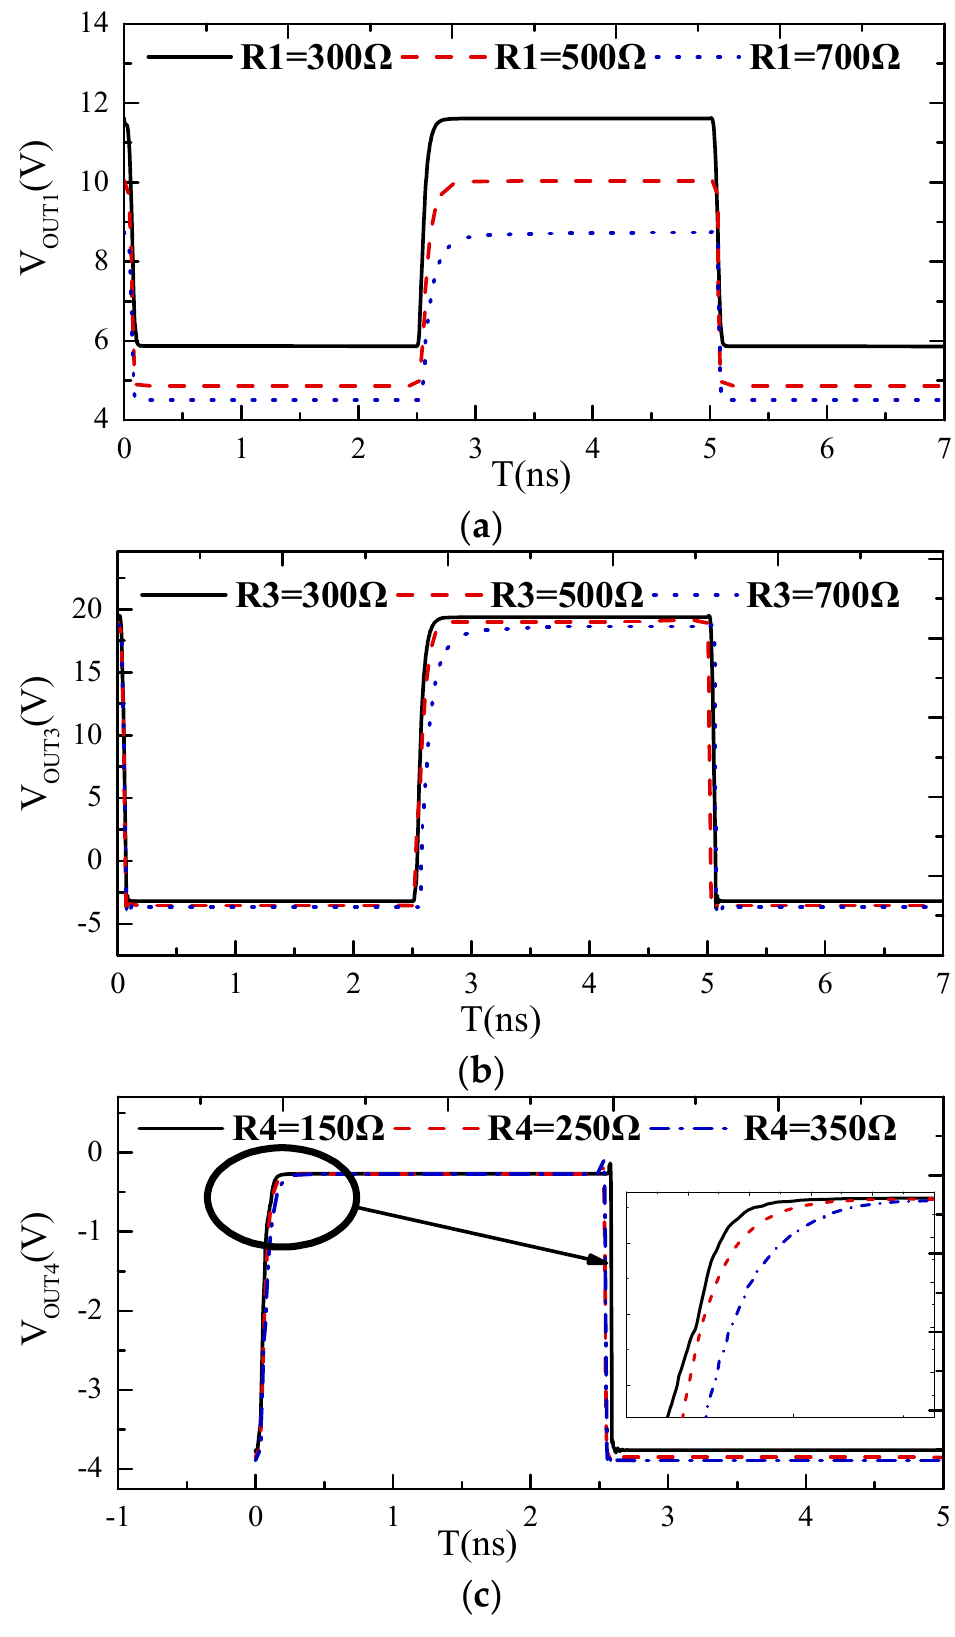
Figure 4. The simulated output waveform: ( a ) 1st stage, ( b ) left side of the 3rd stage and ( c ) right side of the 3rd stage.